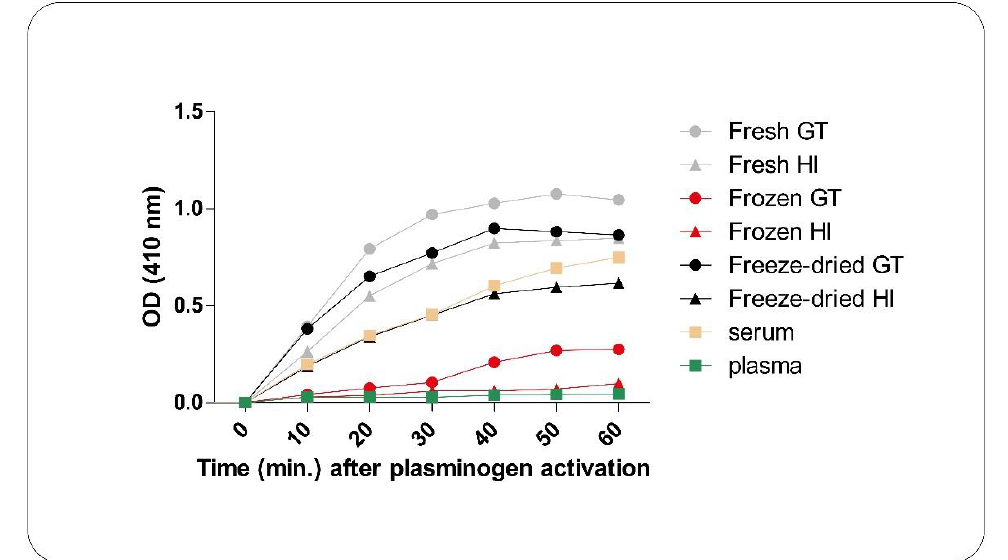
Figure 8. Plasmin activity of fresh, frozen and freeze-dried GT and HI PRF membranes. We used plasma samples as negative control and serum samples as positive control.